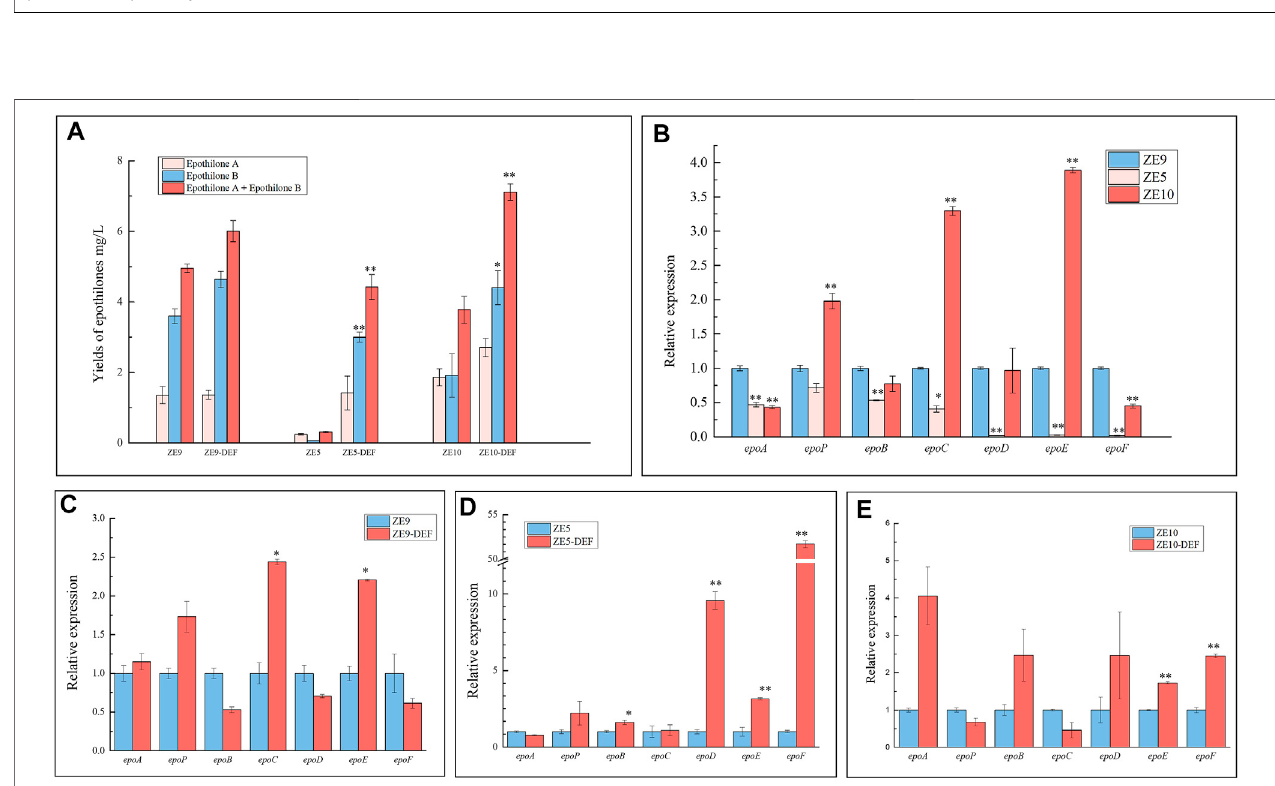
FIGURE 4 | Combined activation of promoters in an operon. (A) RT-qPCR analysis of expression levels of the seven operon genes in the activation mutants after 48 h of incubation. The expressions of the seven operon genes in M . xanthus ZE9 were each set as 1, and the expressions of the genes in mutant strains are shown as the relative expression. (B) Yields of epothilone A and epothilone B in M . xanthus ZE9 and the activation mutants. The error bars represent the standard deviation of three independent experiments. For statistical analysis between the ancestral strain and mutant strains, the signals of ** and * mean p < 0.01 and p < 0.05, respectively.